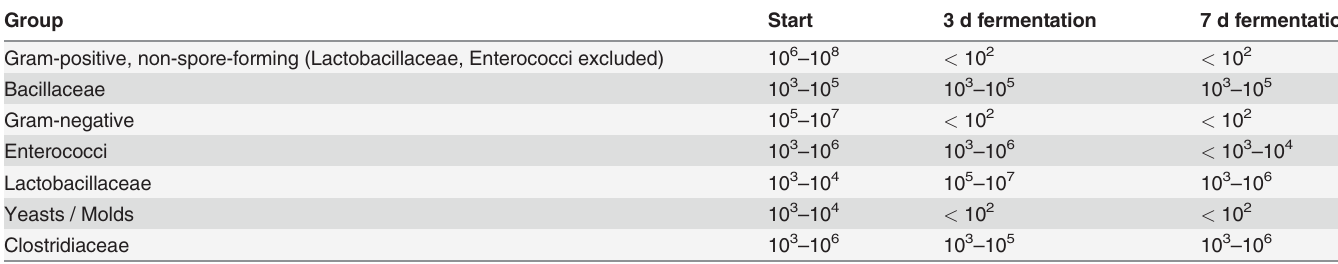
Table 3. General overview of a typical community shift (cfu/g). Group